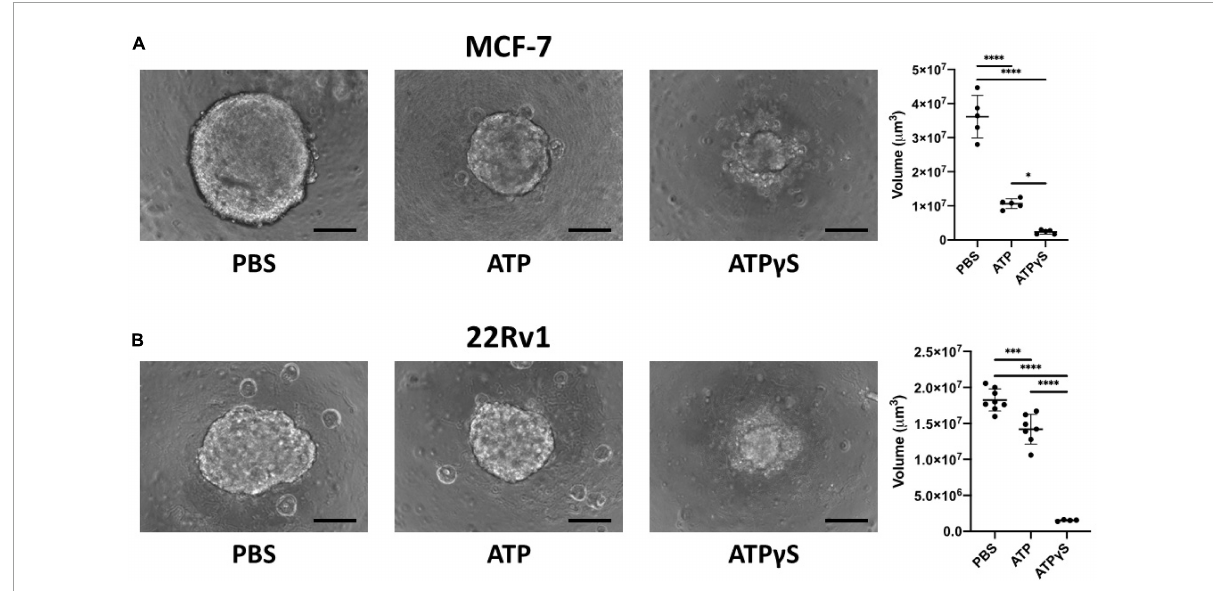
FIGURE5 Extracellular ATP (eATP) inhibits MCF-7 and 22Rv1 breast cancer cell growth in 3D culture and non-hydrolyzable ATP analog ATP γ S causes stronger reduction. We cultured 2000 MCF-7 (A) or 22Rv1 (B) cells in 3D culture conditions for 1 week with 1mM ATP, ATP γ S or vehicle before acquiring images using a Keyence BZ-X710 microscope and determining sphere volume. ATP significantly inhibited the sphere size compared to vehicle, and its non-hydrolyzable analog significantly further reduced sphere size. One-way ANOVA with Tukey’s post-test was used for pairwise comparisons. ∗ p < 0.05; ∗∗∗ p < 0.001; ∗∗∗∗ p < 0.0001. Scale bar = 200 µ